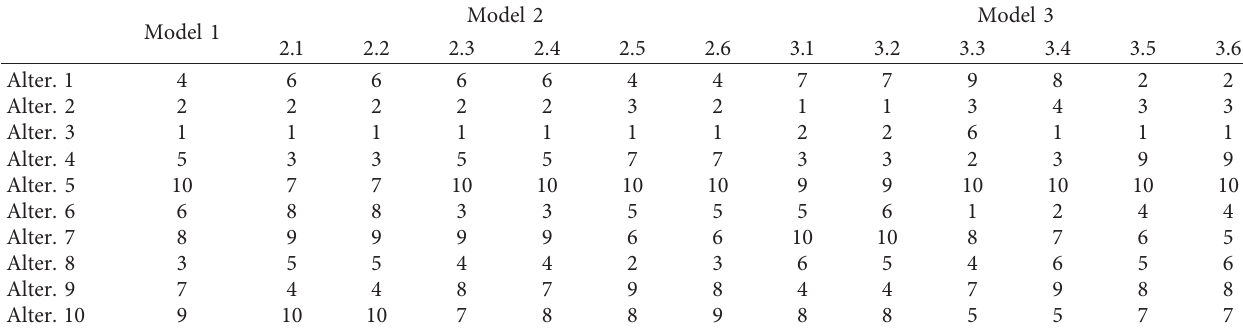
Table 15: Comparison of the ranks of alternatives according to models 1, 2, and 3. Model 1